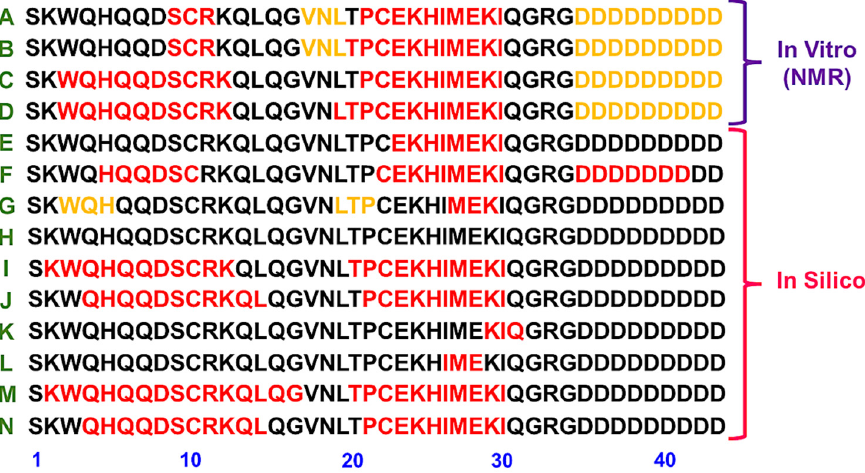
Figure 2. Lunasin secondary structure content location from the published literature. ( A , B ) Secondary structure elements identified by NMR for the recombinant lunasin at pH 3.5 without or with disulfide bond, respectively [36]. ( C , D ) Secondary structure elements identified by NMR for the recombinant lunasin at pH 6.5 without or with disulfide bond, respectively [36]. ( E ) Proposed α -helix motif with similarity to chromatin-binding proteins [14]; ( F ) Structural content observed by molecular dynamics simulations [37]; ( G , H ) Reduced and oxidized forms of the extended lunasin model analyzed by molecular dynamic studies in water [24], respectively. ( I , J ) Reduced and oxidized forms from the predicted lunasin model analyzed by molecular dynamic studies in water [24], respectively. ( K , L ) Reduced and oxidized forms, respectively, from the extended lunasin model analyzed by molecular dynamic studies in mixture of water and TFE [24]. ( M , N ) Reduced and oxidized forms, respectively, from the predicted lunasin model analyzed by molecular dynamic studies in mixture of water and TFE [24]. Residues in red are α -helix motifs and residues in yellow are from a β